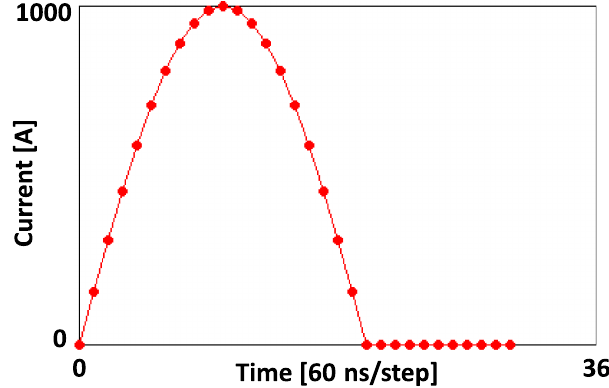
FIG. 10. Temporal evolution of the supplied current for six coils.